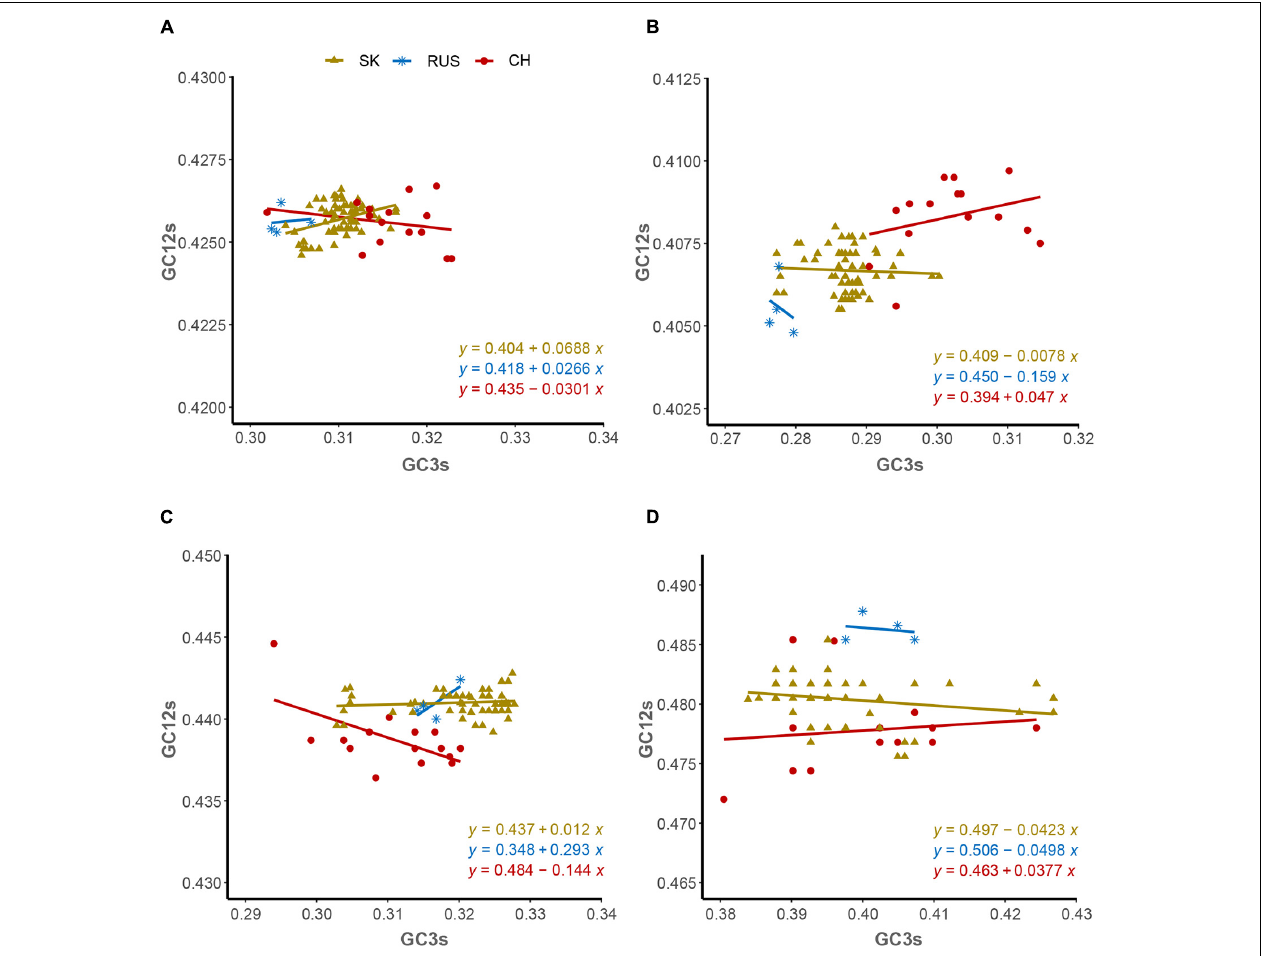
FIGURE 6 | Neutrality plot analysis. (A) Overall genome, (B) L-segment, (C) M-segment, and (D)